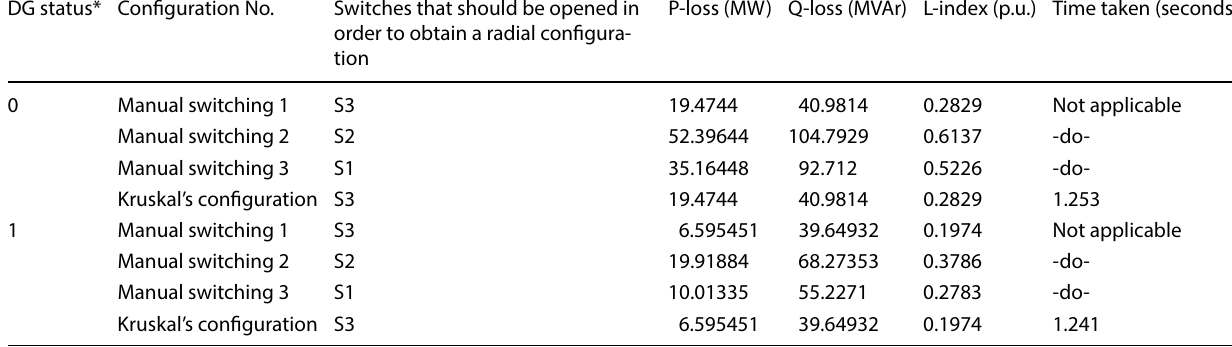
*Where, 0 = network without DG, and 1 = network with